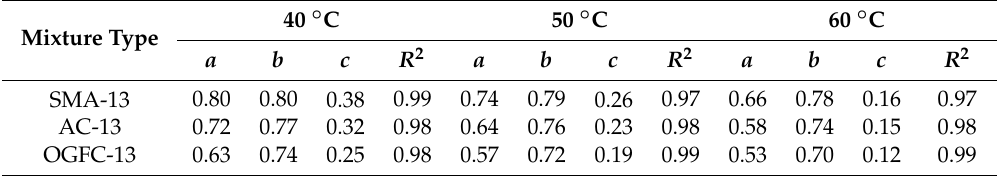
Table 6. Parameters of failure envelope in σ − τ